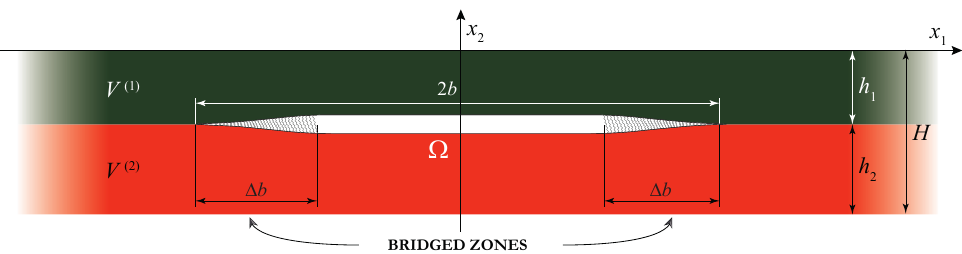
Figure 2. Two-layered laminate with a strip-like damaged zone including possible bridged